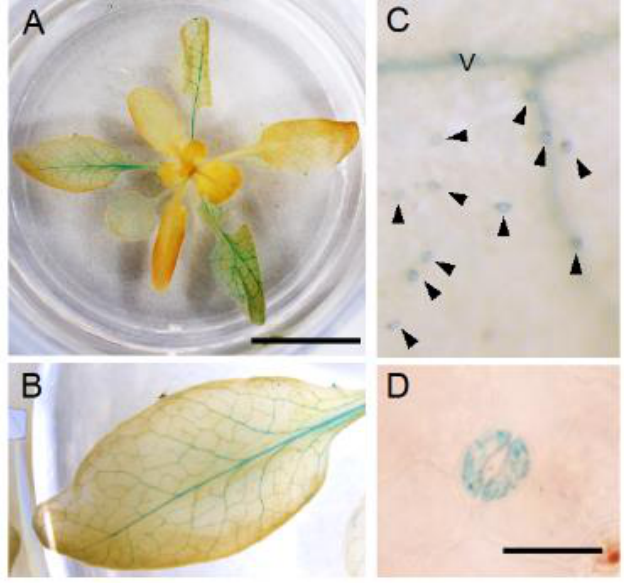
Figure 2. GUS staining of pNPF4.6:gNPF4.6-GUS plants. ( A ) A rosette (approximately 3 weeks old). Scale bar = 1 cm. ( B ) Close-up view of a leaf from ( A ). ( C ) Close-up view of the leaf surface. Arrowheads indicate guard cells. V denotes vascular tissues. ( D ) Close-up view of a pair of guard cells. Scale bar = 20 μm. Plants were grown in continuous light.